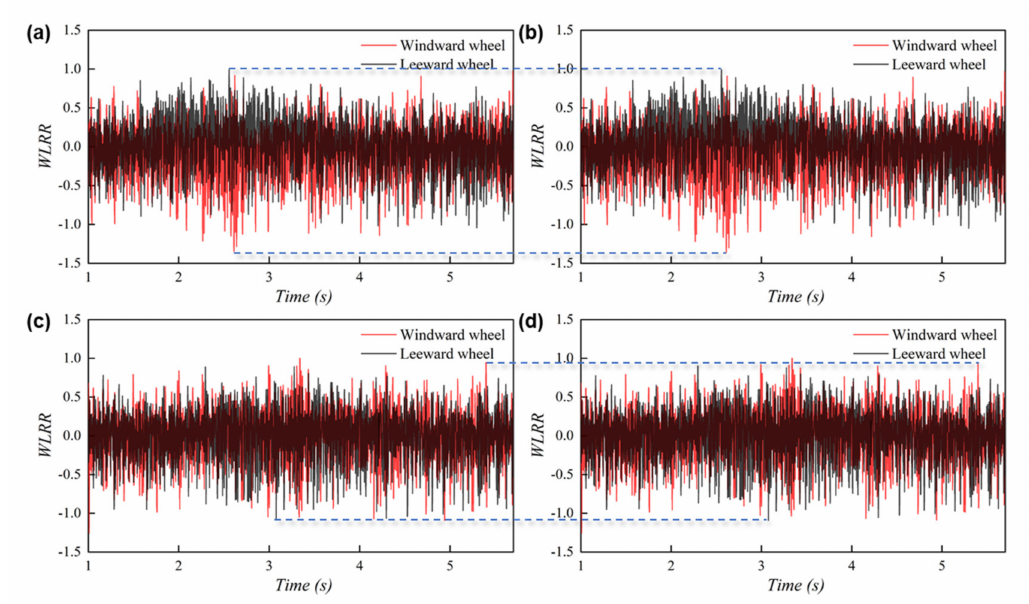
Figure 15. Time-varying WLRR values of two wheelsets: ( a ) the first wheelset of the leading car without posture; ( b ) the first wheelset of the leading car with posture; ( c ) the last wheelset of the trailing car without posture; ( d ) the last wheelset of the trailing car with